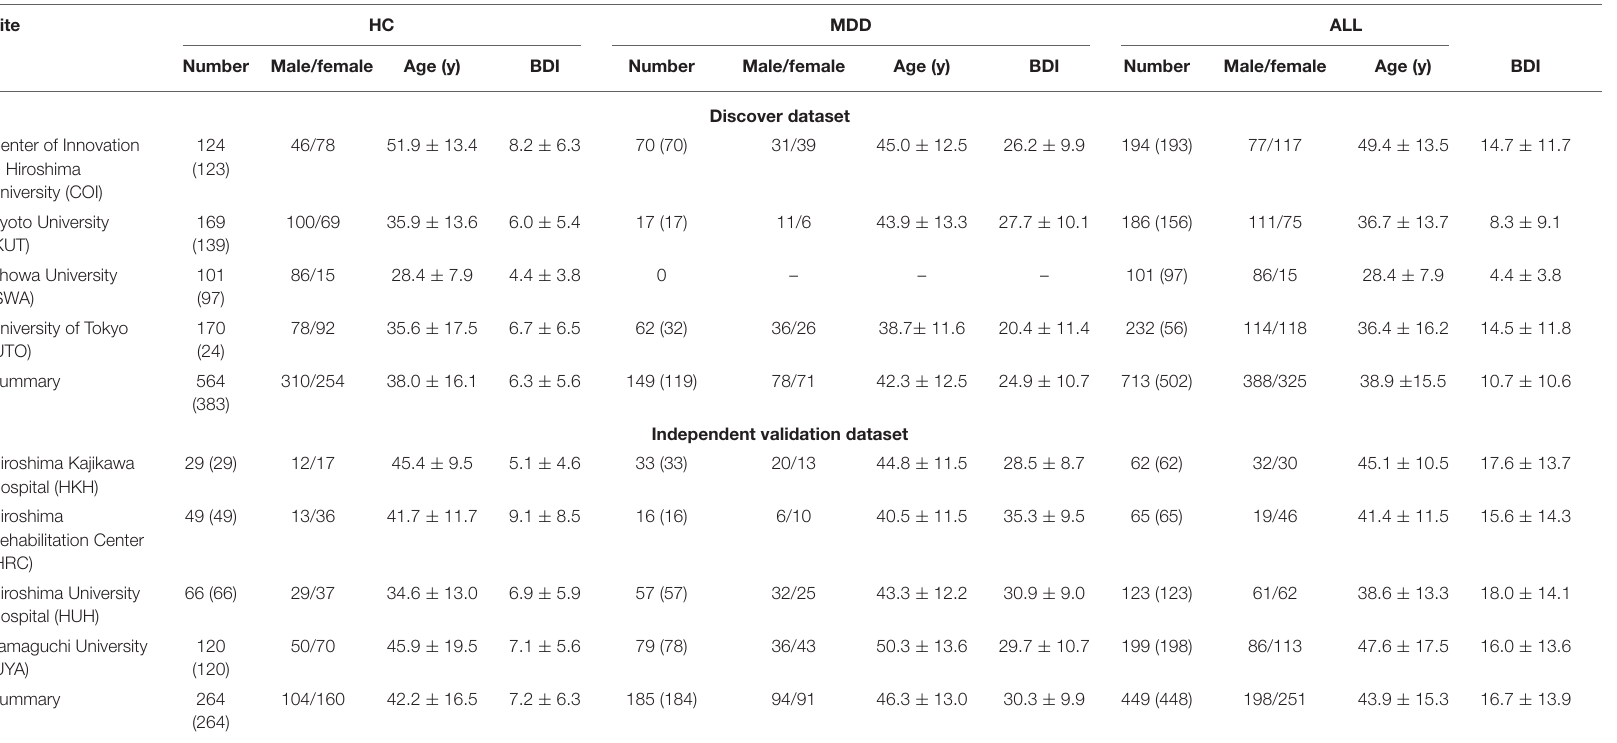
TABLE 1 | Demographic characteristics of participants in both